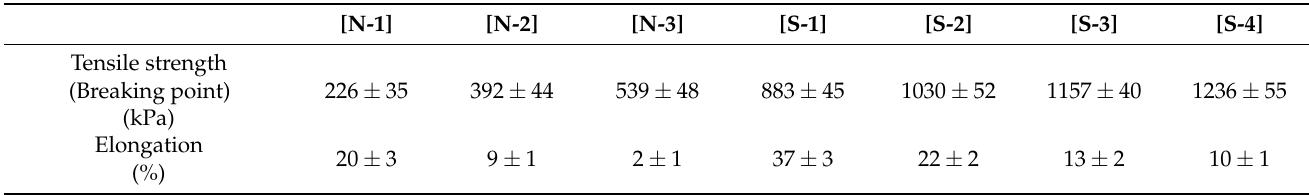
Table 3. The mechanical properties of the TPS/PBAT composites.